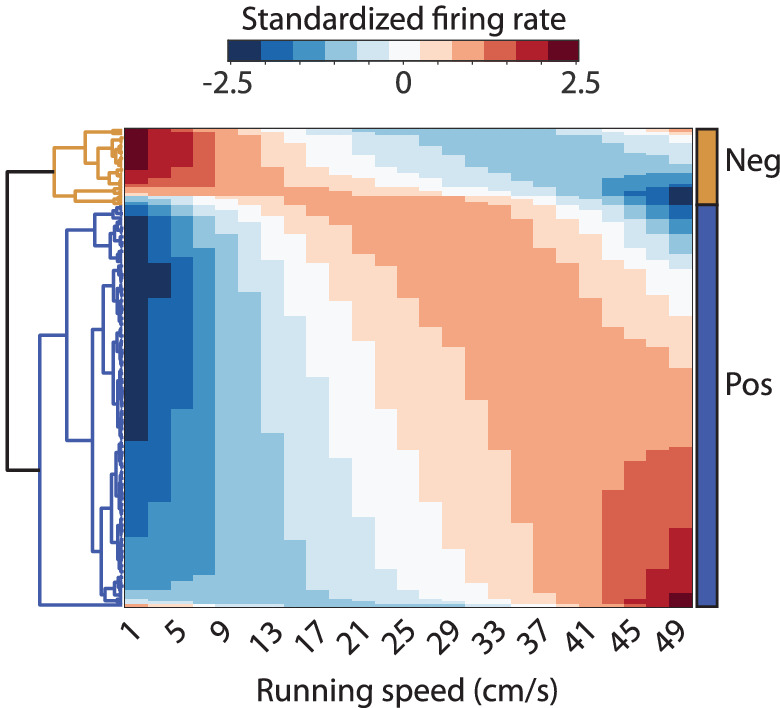
Clustergram visualizing the results of the hierarchical clustering of neurons by similarity of speed modulation of firing rates.The clustering was performed on the neurons’ average speed response curves across light and dark conditions fitted by a quadratic polynomial.